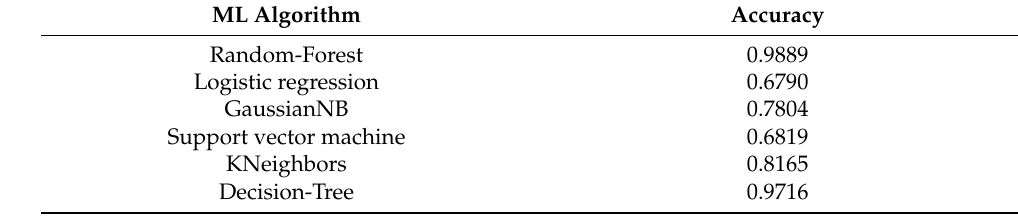
Figure 11. Bar chart visualization of F1 score comparison among different ML algorithms.